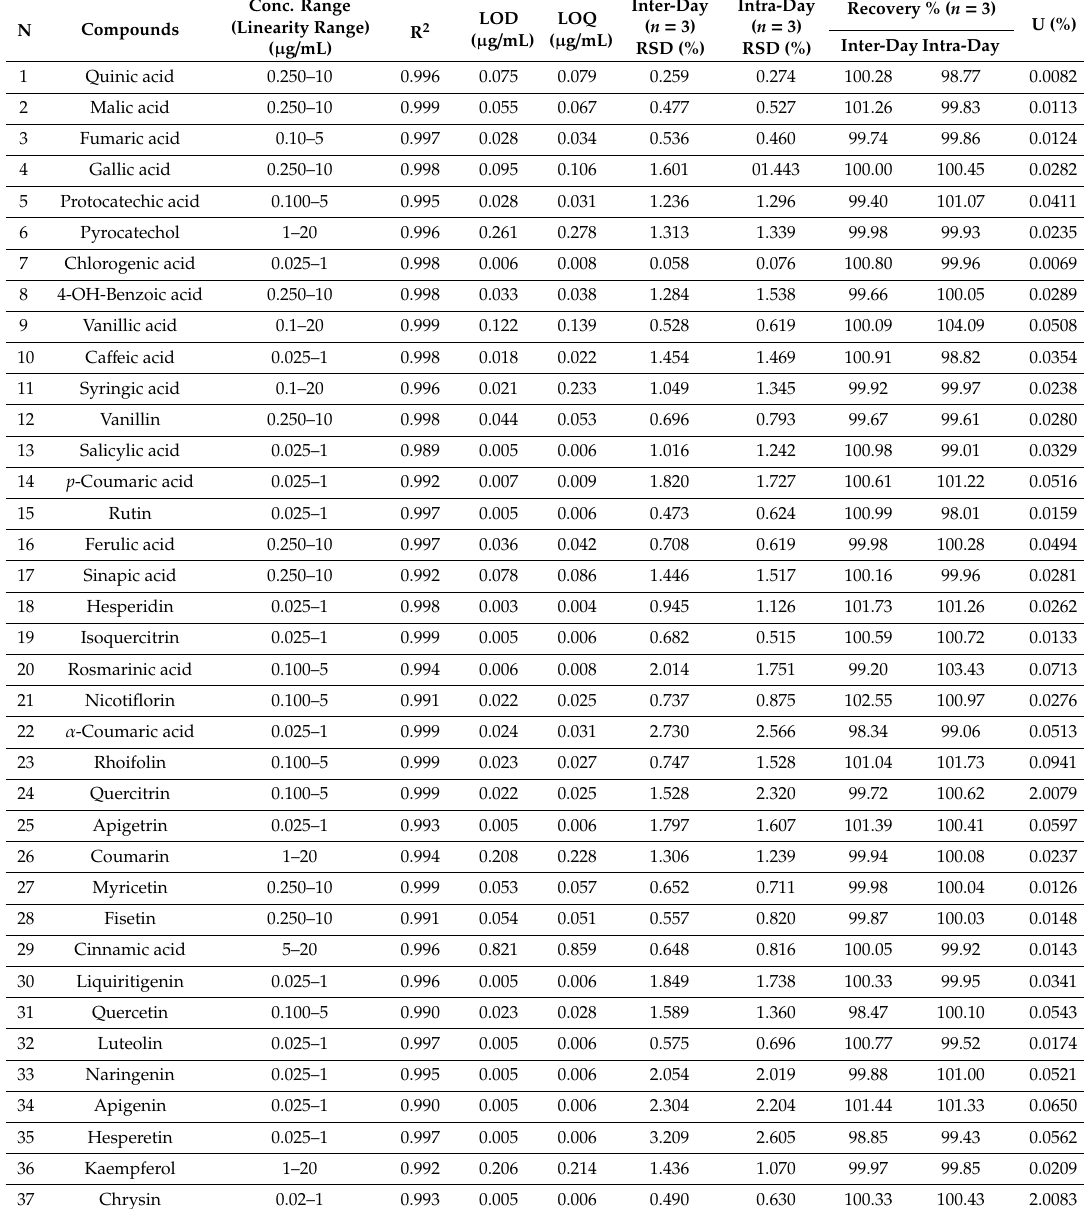
Table 2. Concentration range, linearity (R 2 ), Limits of Detection (LODs), Limits of Quantification (LOQs) and percentages of recoveries of the analysed 37 compounds by LC–MS /